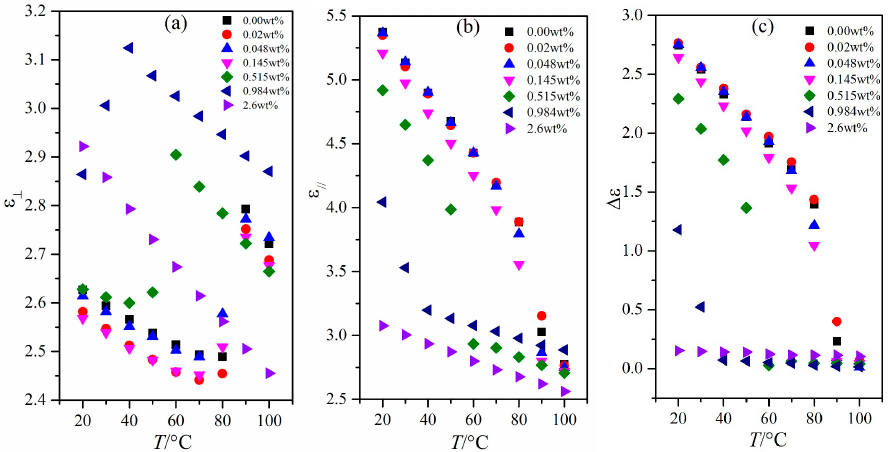
Figure 5. Dependence of the dielectric constants ( a ) ε ⊥ and ( b ) ε // and the dielectric anisotropy ( c ) Δ ε